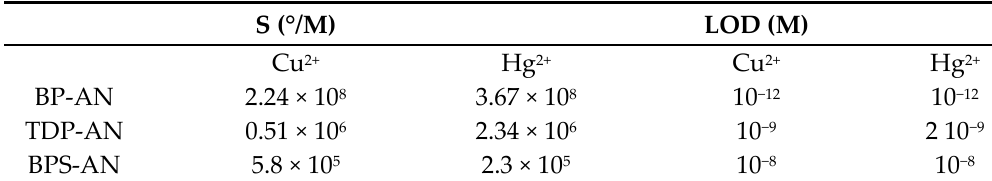
Table 1. Calculated sensitivities towards Hg 2+ and Cu 2+ ions and estimated limit of detection of SAW sensors functionalized with anthracene